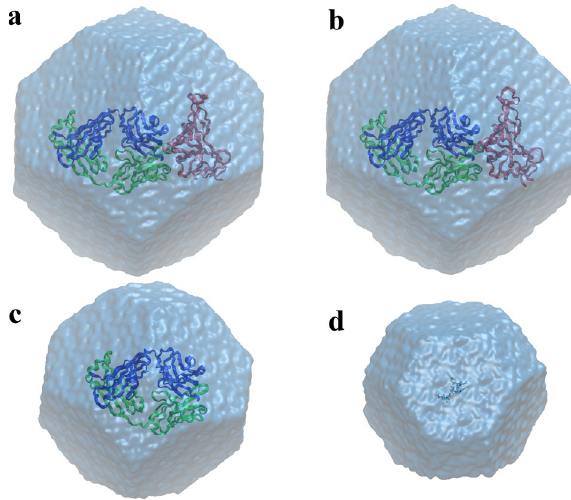
Figure 2. Four simulation systems in this study. ( a ) Complex of the m396 Fab and the SARS-CoV-1 RBD. ( b ) Complex of the m396 Fab and the SARS-CoV-2 RBD. ( c ) m396 Fab. ( d ) A 7-residue peptide representing the local structure of denatured antibody. Images were rendered by VMD 43 (version